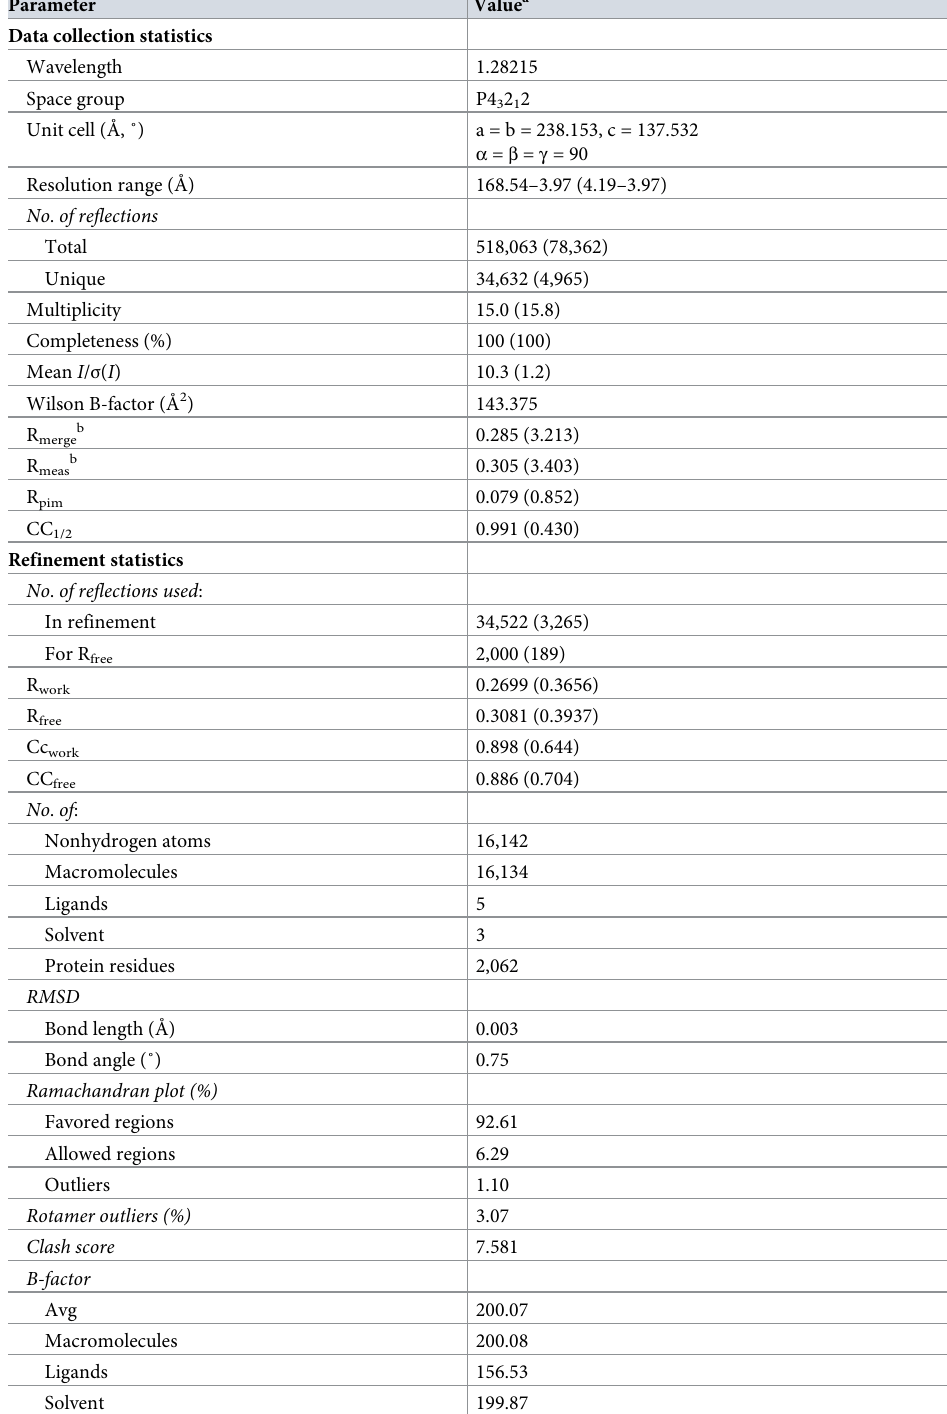
Table 1. Data collection and refinement